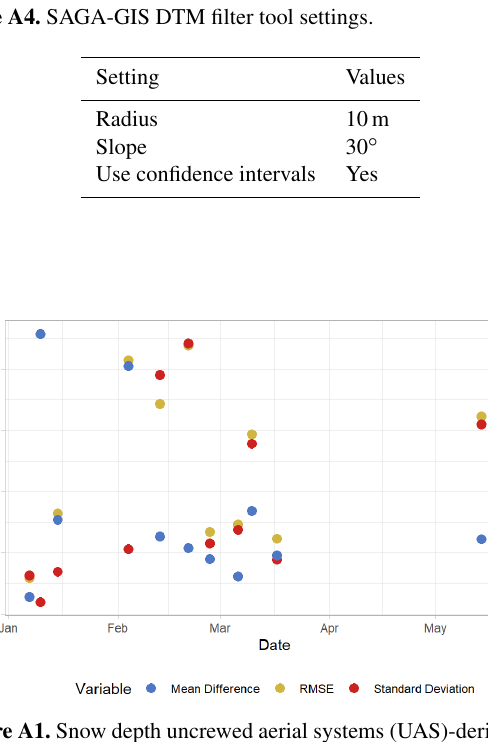
Table A5. Resolution-averaged root mean squared error (RMSE) and normalized median absolute deviation (NMAD) of